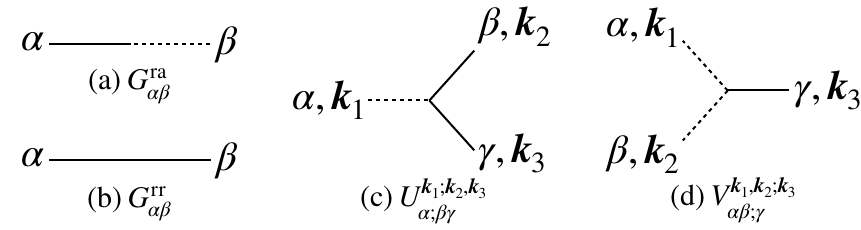
, (b) G rr , and the vertices (c) U and (d) V . αβ αβ